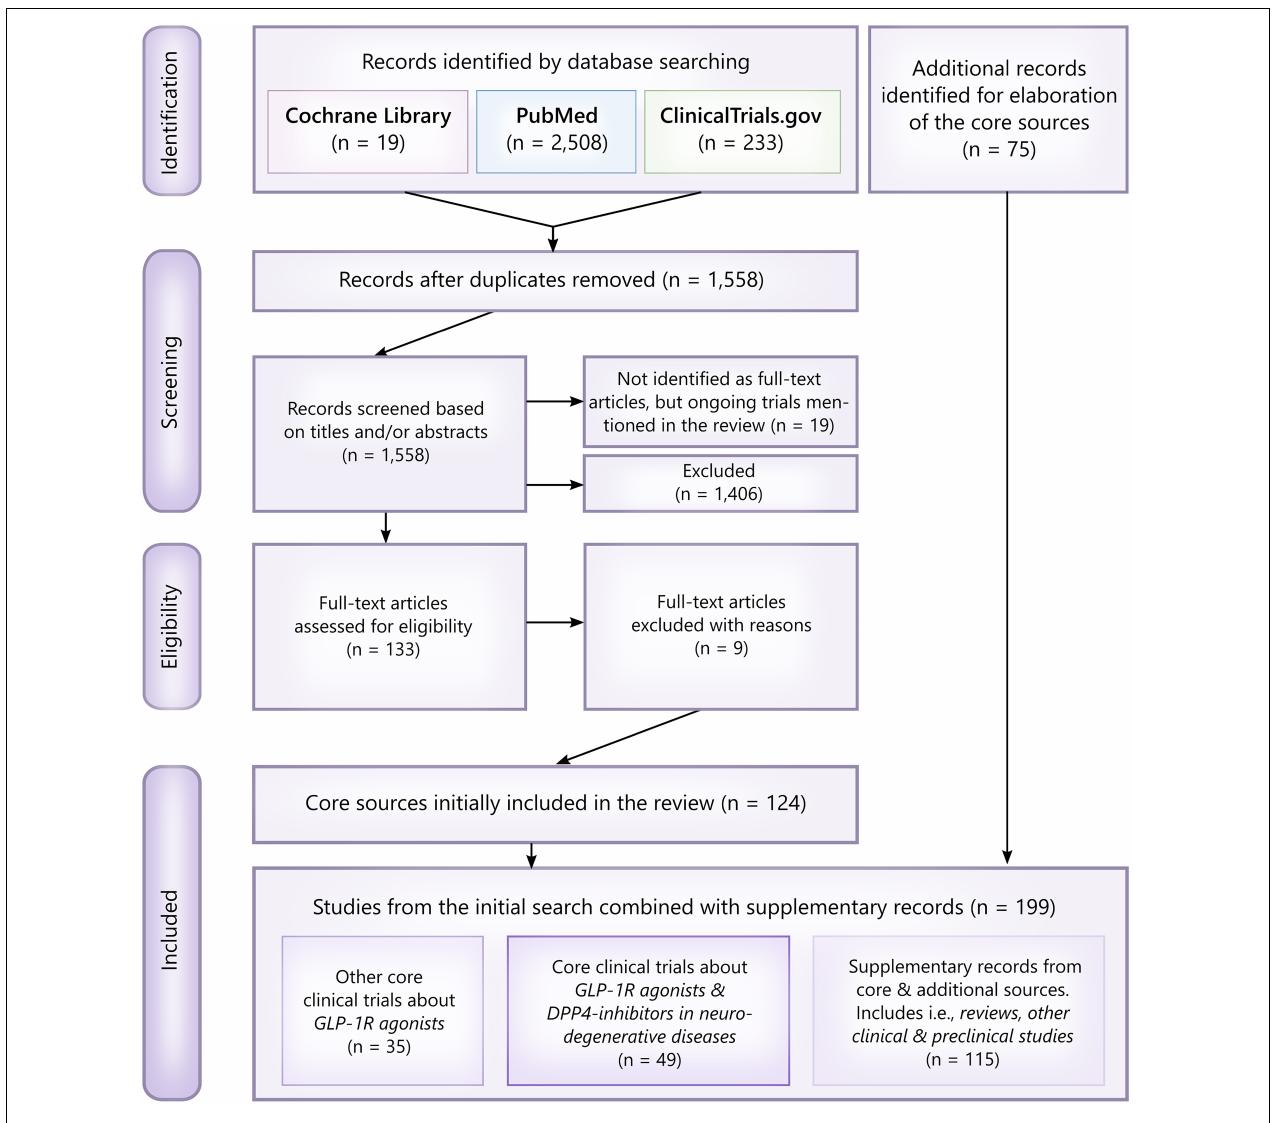
FIGURE 1 | PRISMA flowchart and overview of the literature search. Studies were primarily excluded based on their clinical relevance and whether or not they assessed a neuroprotective effect of GLP-1R agonists/DPP4-inhibitors or not. Thus, included core studies were assessed as eligible if identified as randomized clinical trials, pilot studies, other interventional studies, epidemiological studies (cohort studies, case-control studies, etc.) and studies analyzing samples from clinical trials. For elaboration of the core sources, i.e., reviews, preclinical studies investigating the neuroprotective mechanisms behind GLP-1R agonists, relevant abstracts and post hoc analyses were included as additional records. In total, 199 records were